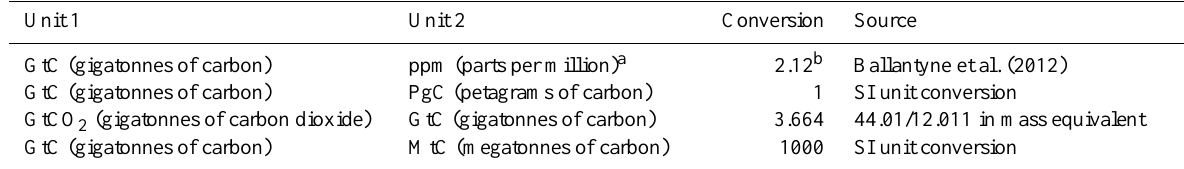
Table 1. Factors used to convert carbon in various units (by convention, unit 1 = unit 2 ·